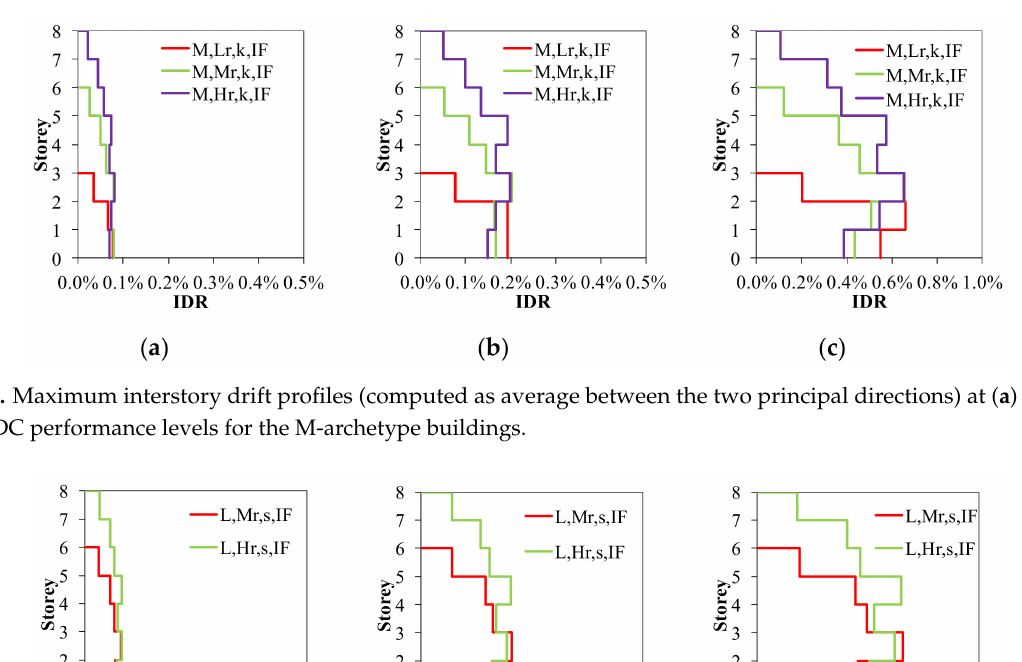
Figure 8. Maximum interstory drift profiles (computed as average between the two principal directions) at ( a ) ZL, ( b ) O, and ( c ) DC performance levels for the H-archetype buildings.